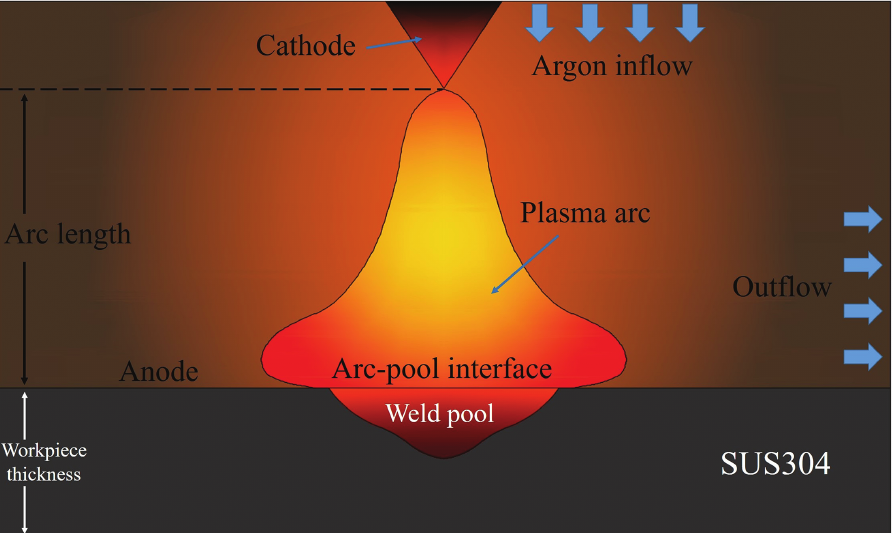
Figure 1: Schematic diagram of TIG welding